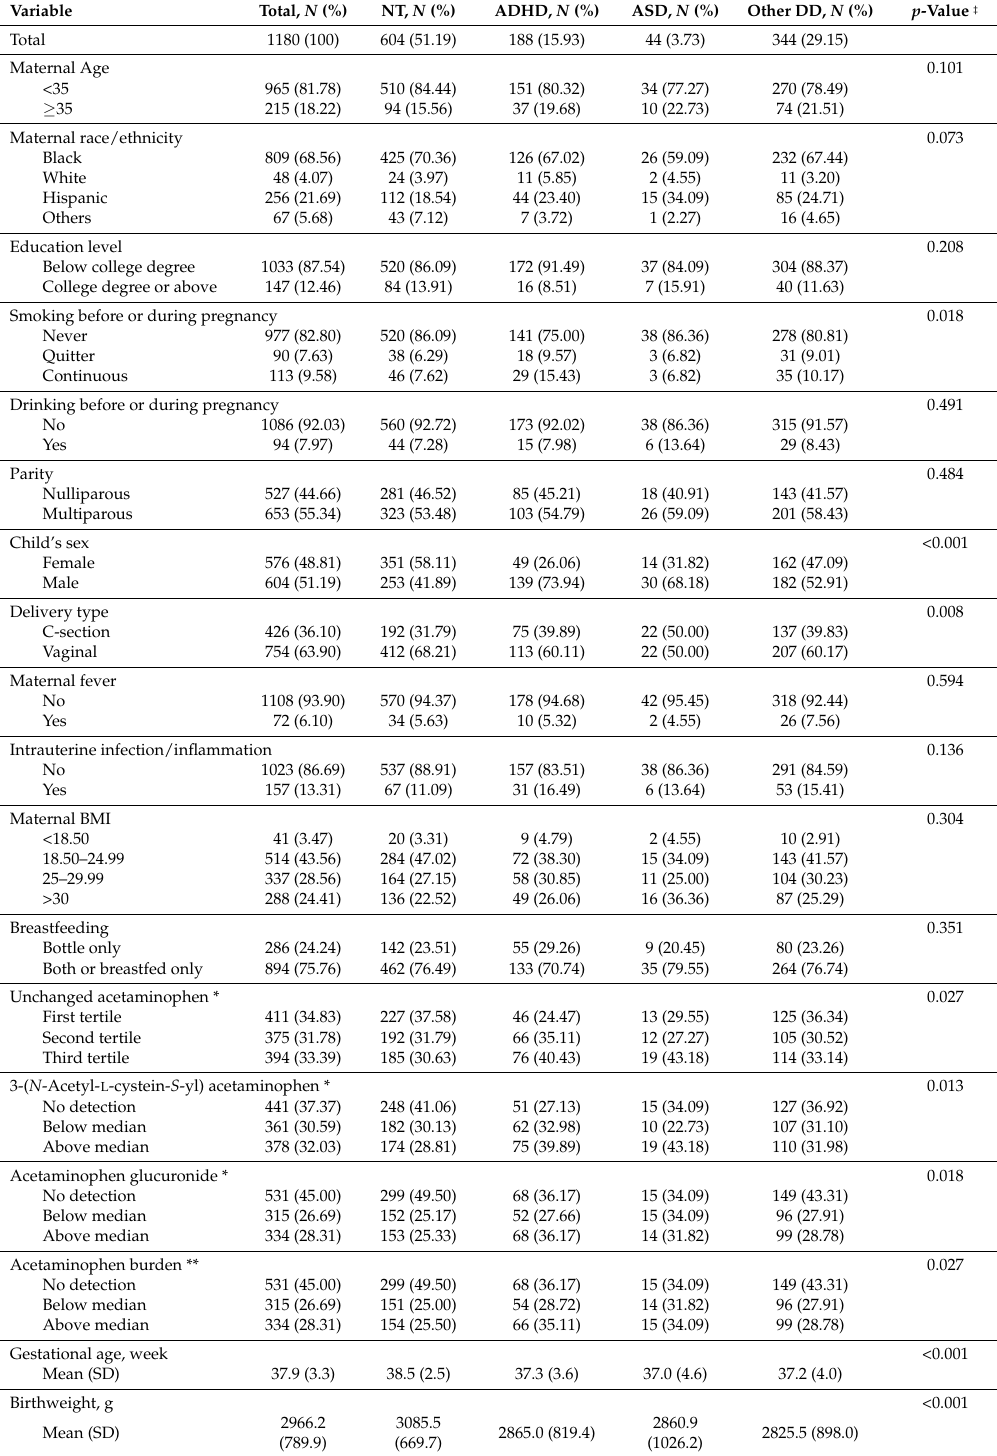
Table 1. Maternal and child characteristics for children with ADHD diagnosis, ASD diagnosis (excluding ADHD), other developmental disorder diagnosis (other DD), and neurotypical children (NT).